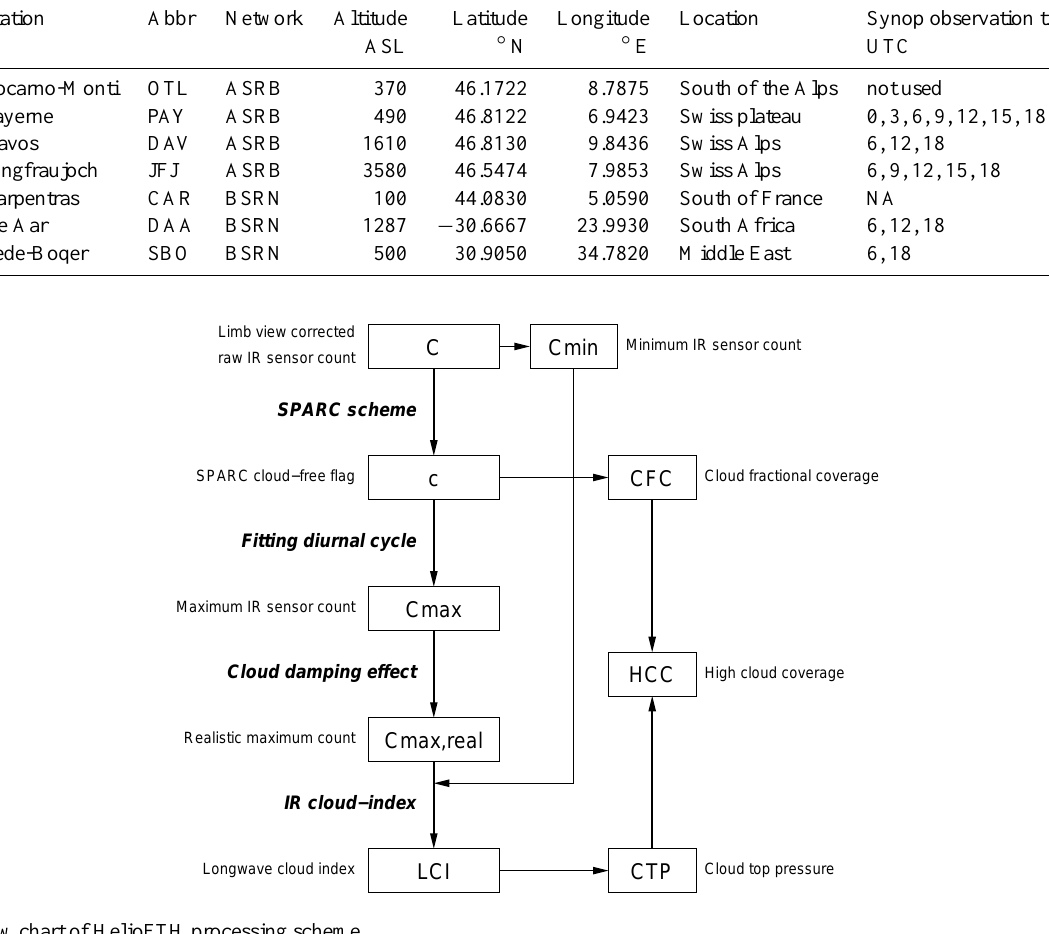
Fig. 1. Flow chart of HelioFTH processing scheme.